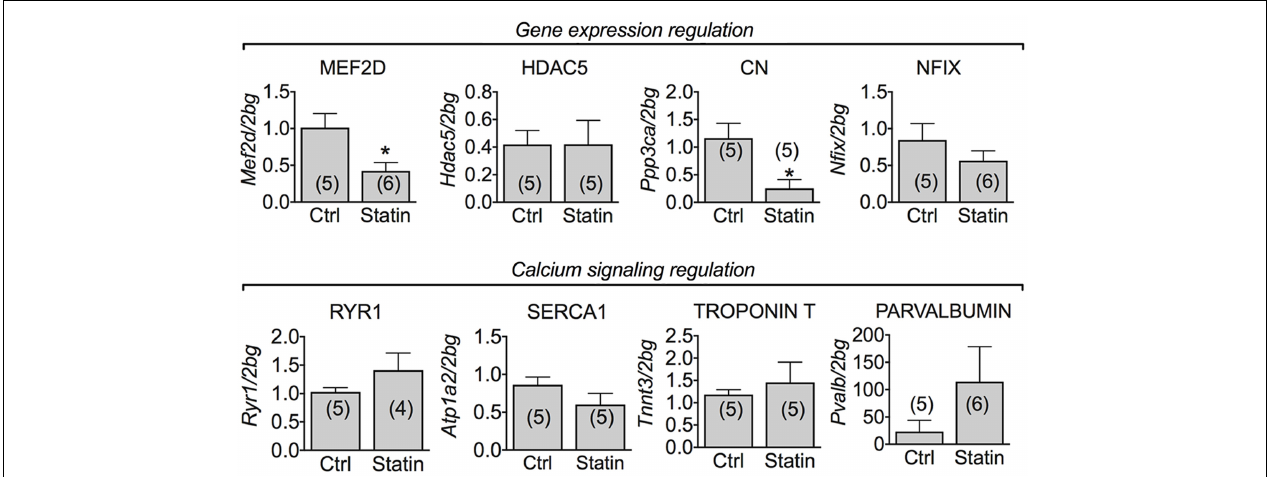
FIGURE 4 | Real-time PCR analysis of mRNA expression level of genes involved in ClC-1 chloride channel regulation and calcium signaling in VL muscle biopsies of patients in therapy with statin showing sign of myopathy. Histograms show quantification of transcript levels for MEF2D, HDAC5, CN, NFix, RyR1, SERCA1, Troponin T and Parvalbumin normalized by the beta-2 microglobulin gene. In each graph, the bars represent the mean values ± SEM in myopathic subjects (Statin) compared with those of untreated subjects (Ctrl) from the number of subjects indicated in brackets. ∗ Significantly different with respect to the own control ( P < 0.05 or less) by Student’s t -test.